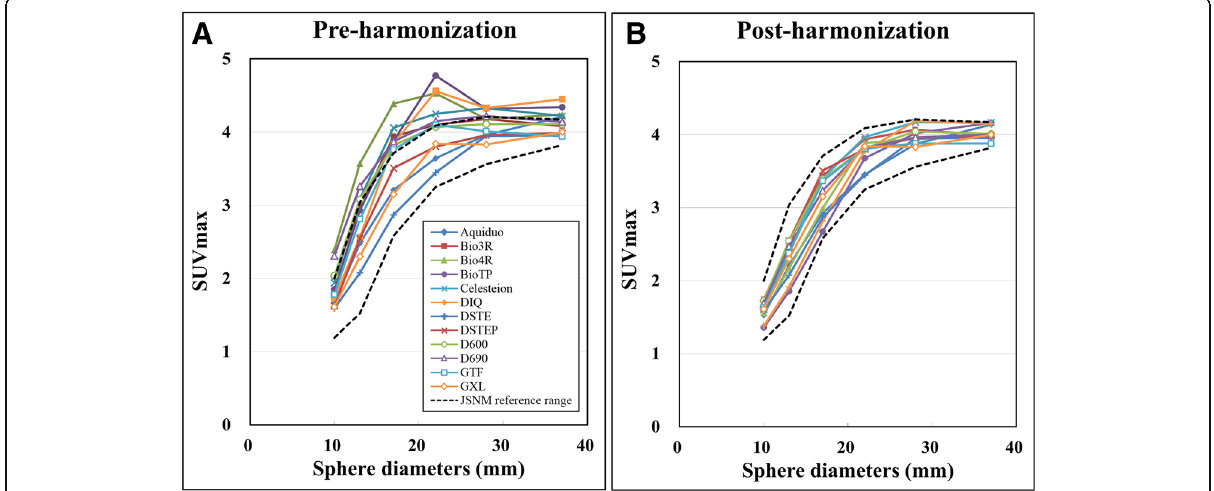
Fig. 3 Recovery coefficients of 12 PET scanners obtained from 30-min PET image. Comparison among a pre- and b post-harmonization